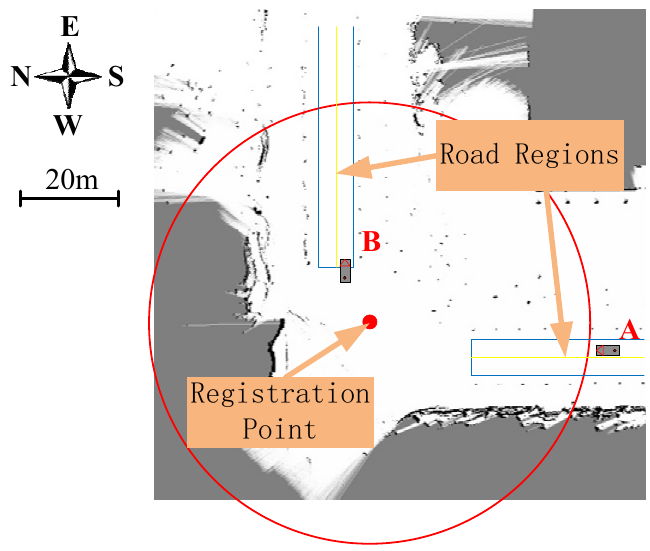
Figure 5. Navigation methods